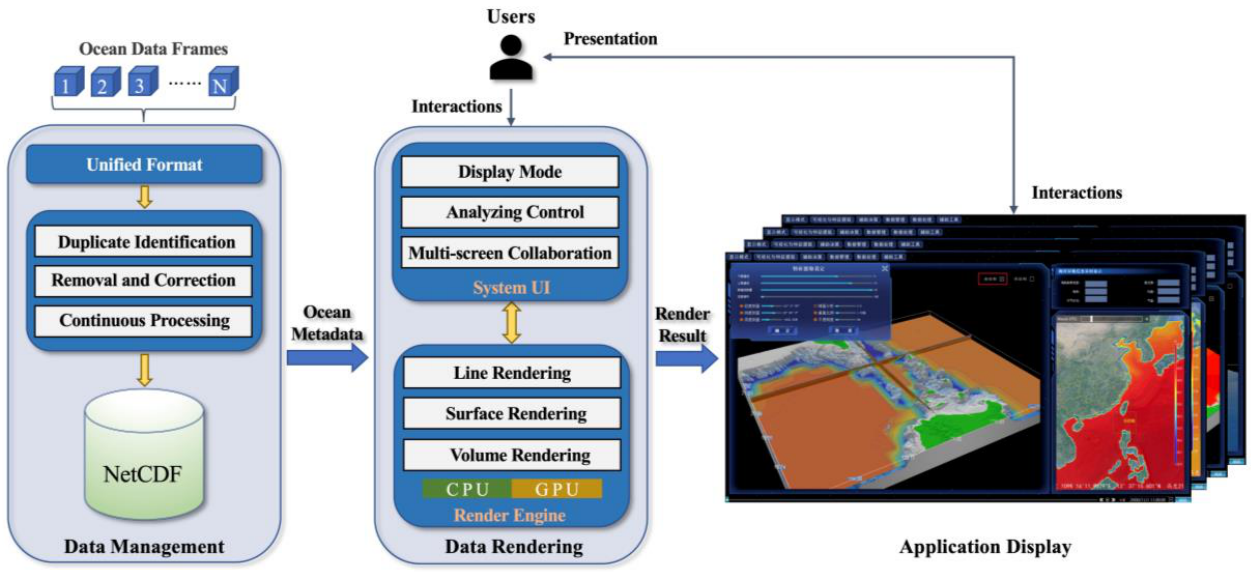
Figure 1. System framework.